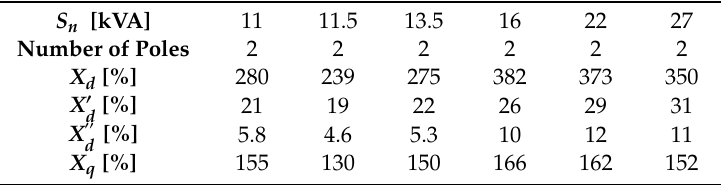
Table 1. Two-poles synchronous generators data with a rated voltage of 400 V from the Linz Electric company